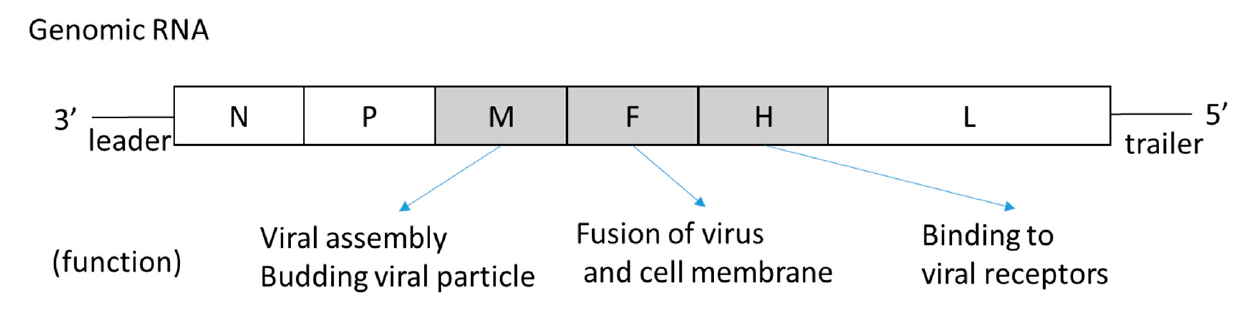
Figure 1. Measles virus genome showing the most common mutations found in SSPE cases. Genes that are mutated in many SSPE viruses compared to wild measles viruses are shown in gray.